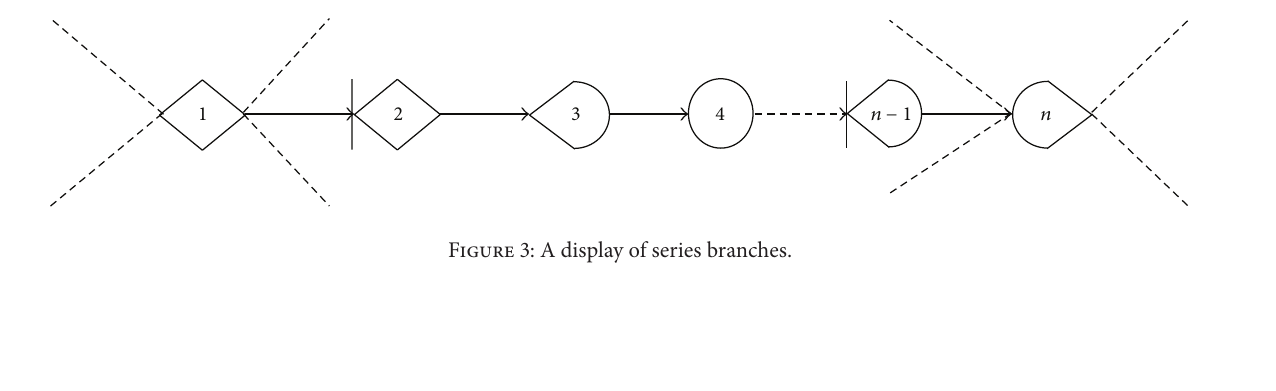
Table 2: Success probability of each branch from node ( 𝑖 ). Qyt. of branch ( 𝑖𝑖